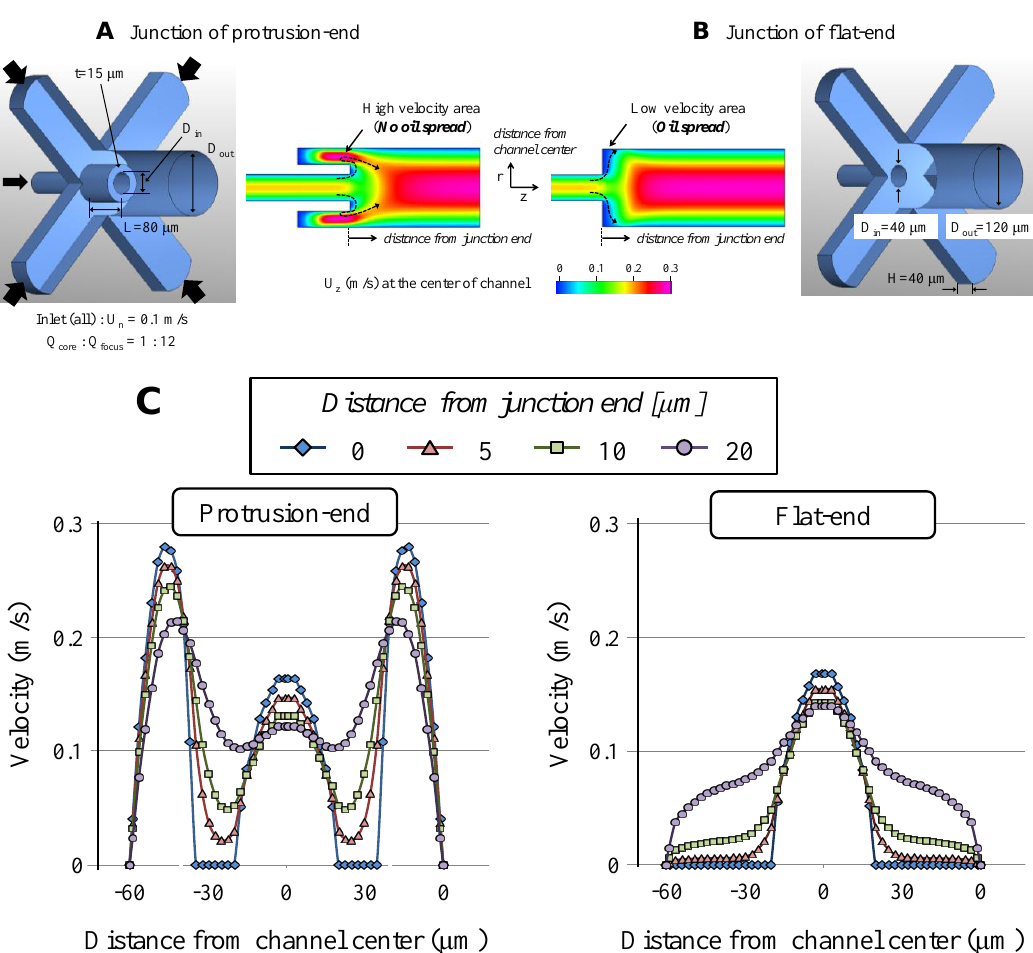
Figure 2. Flow distribution at the junction for droplet formation. ( A ) Protrusion-end structure; and, ( B ) Flat-end structure. ( C ) Velocity distributions in the axial direction at the junction